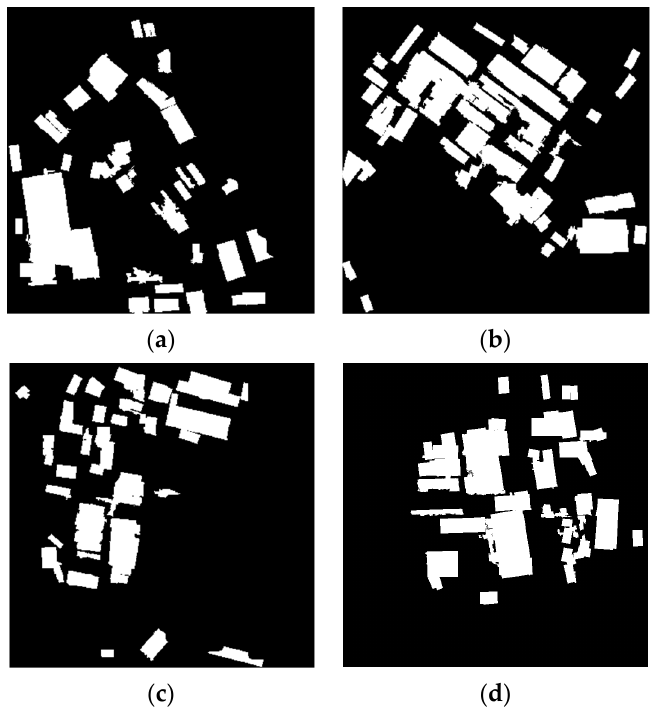
Figure 15. Final obtained building detection results. ( a ) Image I, ( b ) Image II, ( c ) Image III, ( d ) Image ( d ) Image IV.